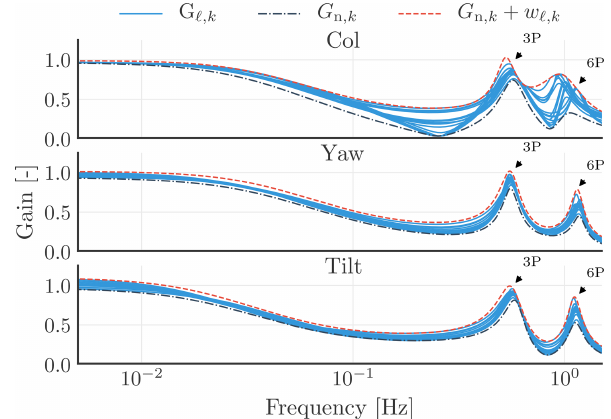
Figure 16. Optimal angular orientation of the telescope. The max- imum frequency ( f max ) in the objective function ( J lp ) is set at 0.1Hz. The blue diamond marks the parameters initially chosen; the red dot marks the maximum point of the function from Eq.